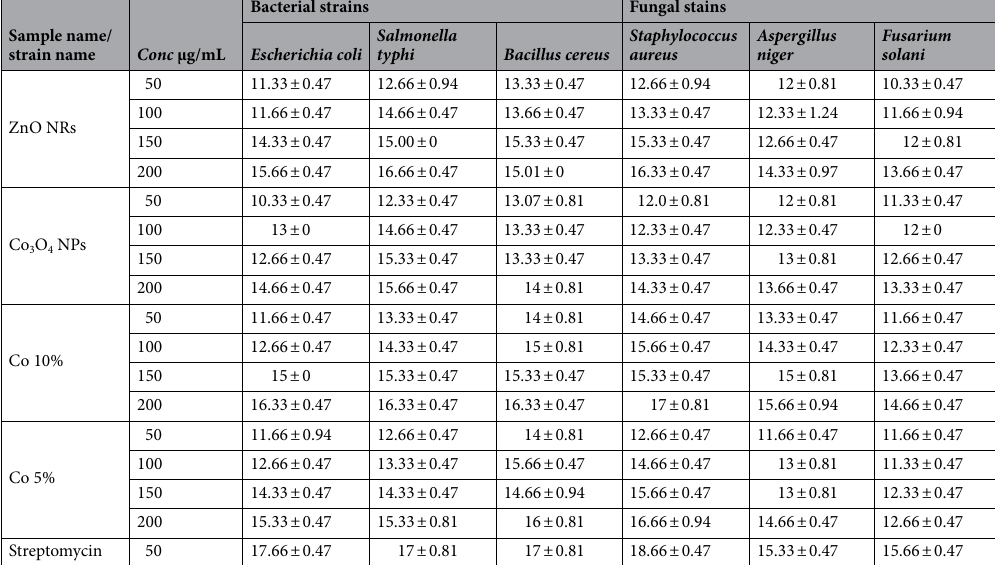
Table 4. Anti-bacterial and anti-fungal effect exhibited by ZnO NRs, Co 3 O 4 NPs, Co 10%, and Co 5% nanocomposite on various test microbes (values in nm) (mean ±